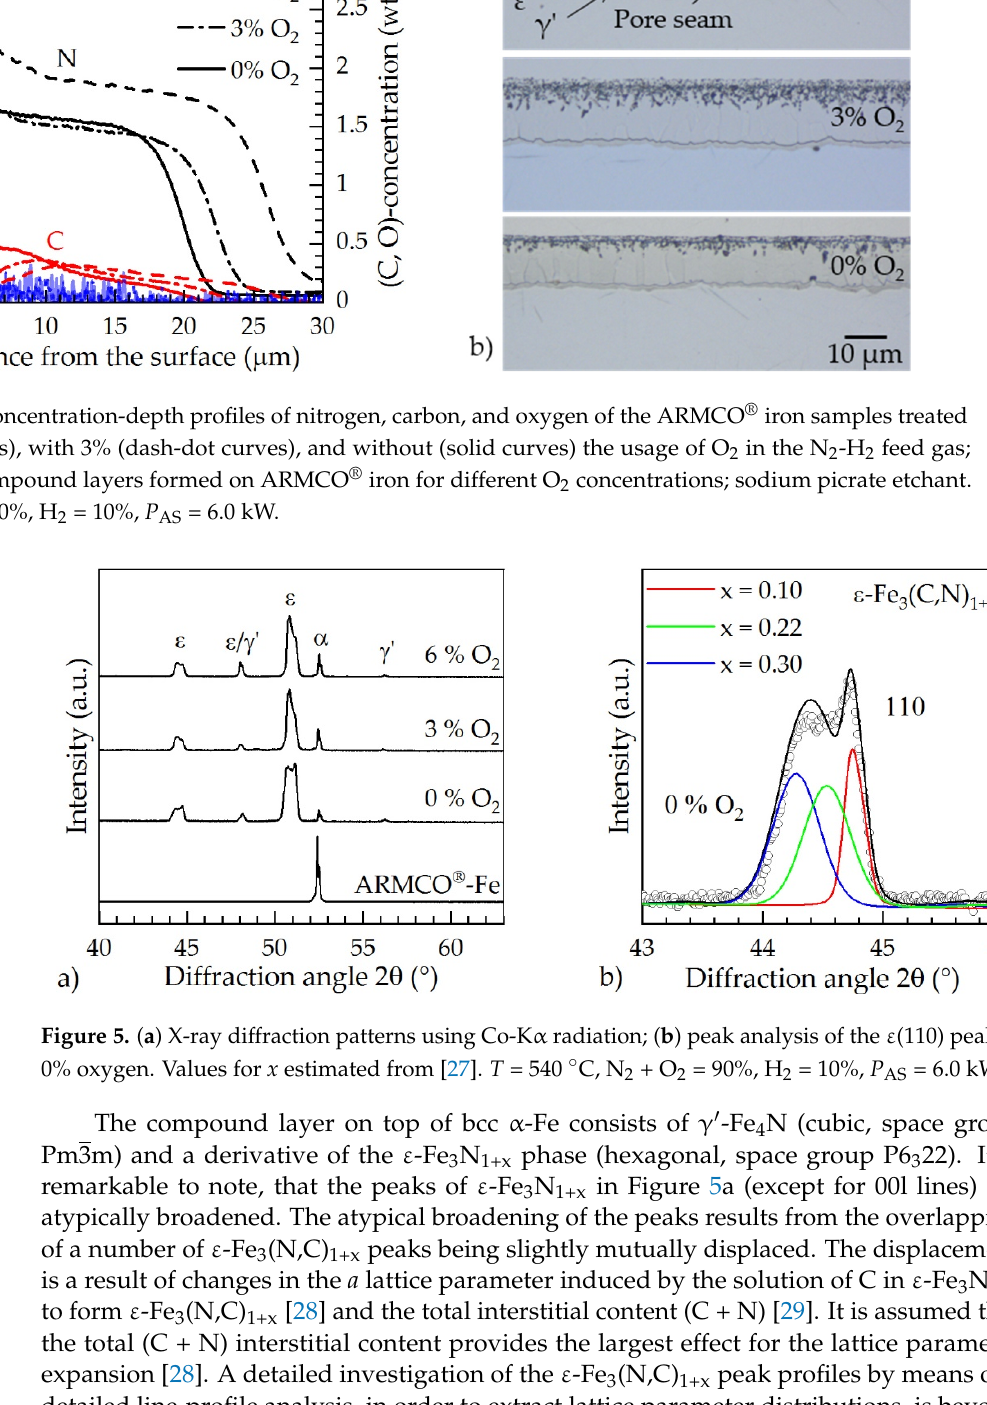
for x estimated from [27]. T = 540 °C, N 2 + O 2 = 90%, H 2 = 10%, P AS = 6.0